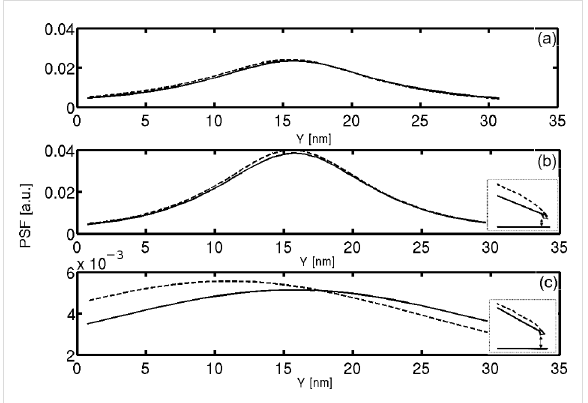
Figure 6: Beam deflection influence on PSF. The dashed line repre- sents the PSF of a deflected beam while the solid one is for a stiff cantilever. Simulation was performed with cantilever first resonance amplitude of 20 nm with a minimum distance of 1 nm. (a) PSF com- parison after averaging; (b) comparison for a probe located at a dis- tance of 1.2 nm above the surface; (c) comparison for a probe located at a distance of 11.9 nm above the surface. Inset figures at (b) and (c) illustrate the deflected and stiff beams that were used for the calcula-